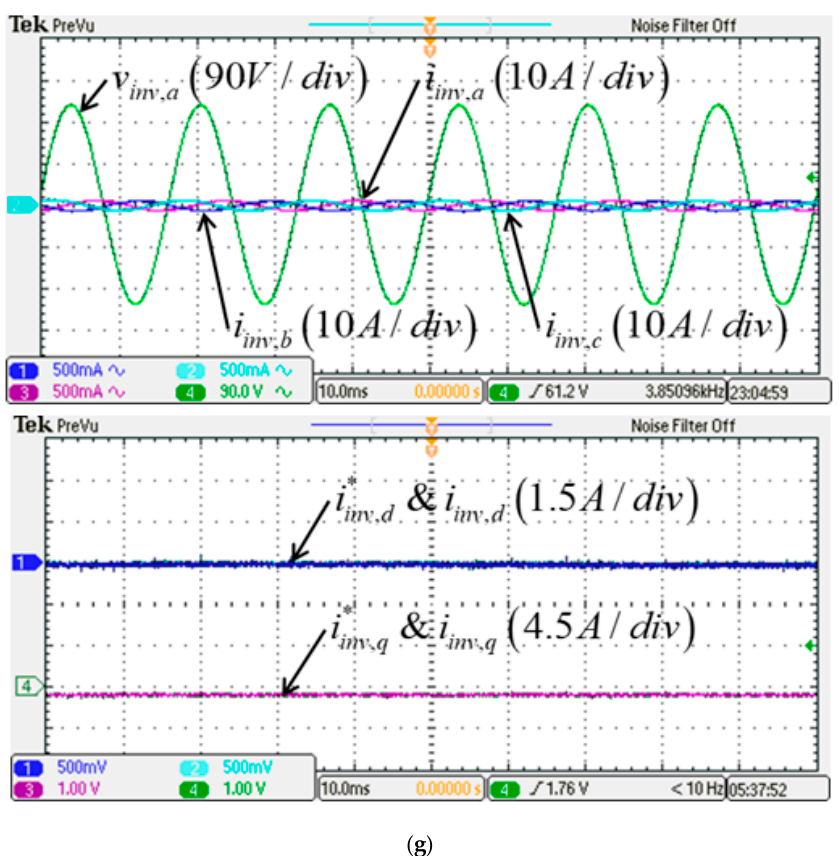
Figure 13. Detailed view of phase A voltage and three-phase currents/inverter dq-axis currents and their commands in Figure 12: ( a ) stage (1); ( b ) stage (2); ( c ) stage (3); ( d ) stage (4); ( e ) stage (5); ( f ) stage (6); ( g ) stage (7).